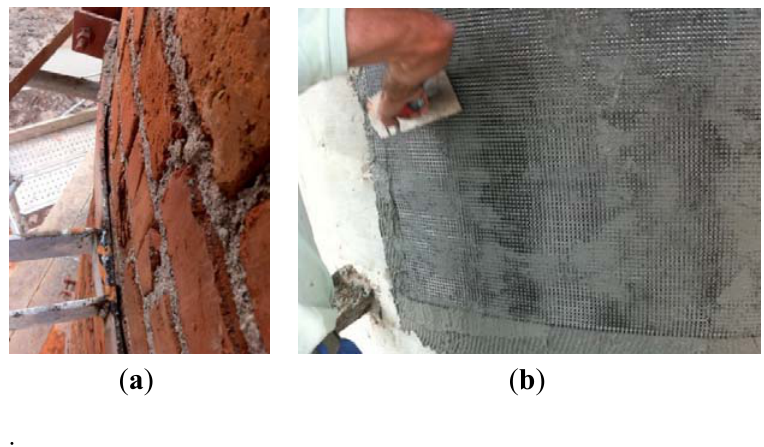
Figure 29. Masonry surface: ( a ) Before; and ( b ) during strengthening.